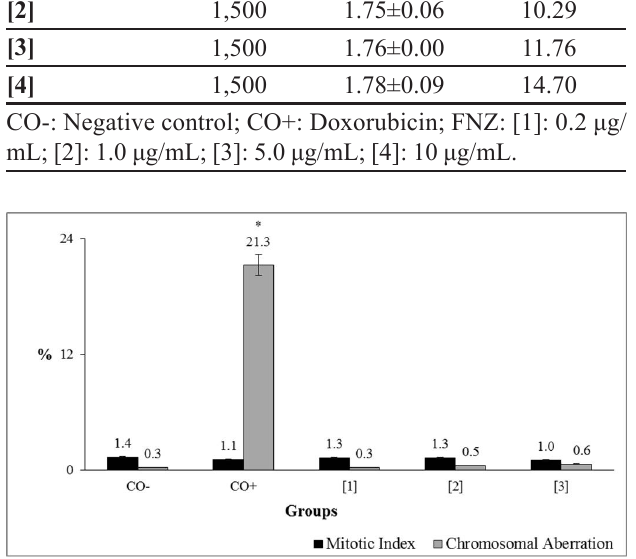
FIGURE 2 - Percentage of the mitotic index and chromosomal aberrations for the negative (CO - ) and positive (CO+) control groups and for groups treated with concentrations of 7 [1], 15 [2] or 30 [3] μg/mL/kg of flunitrazepam in vivo . *Statistically significant result compared with the negative control (p < 0.001).